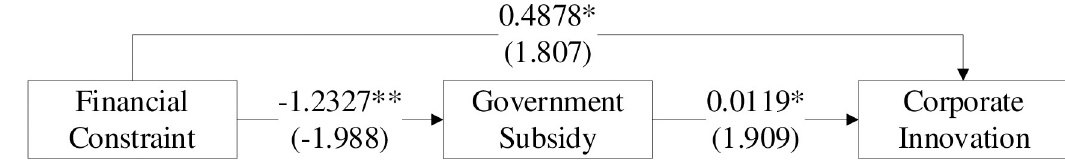
Fig 2. Main results of baseline model. [1] t statistics in parentheses. [2] � , p < 0.1; �� , p < 0.05; ��� , p < 0.01.